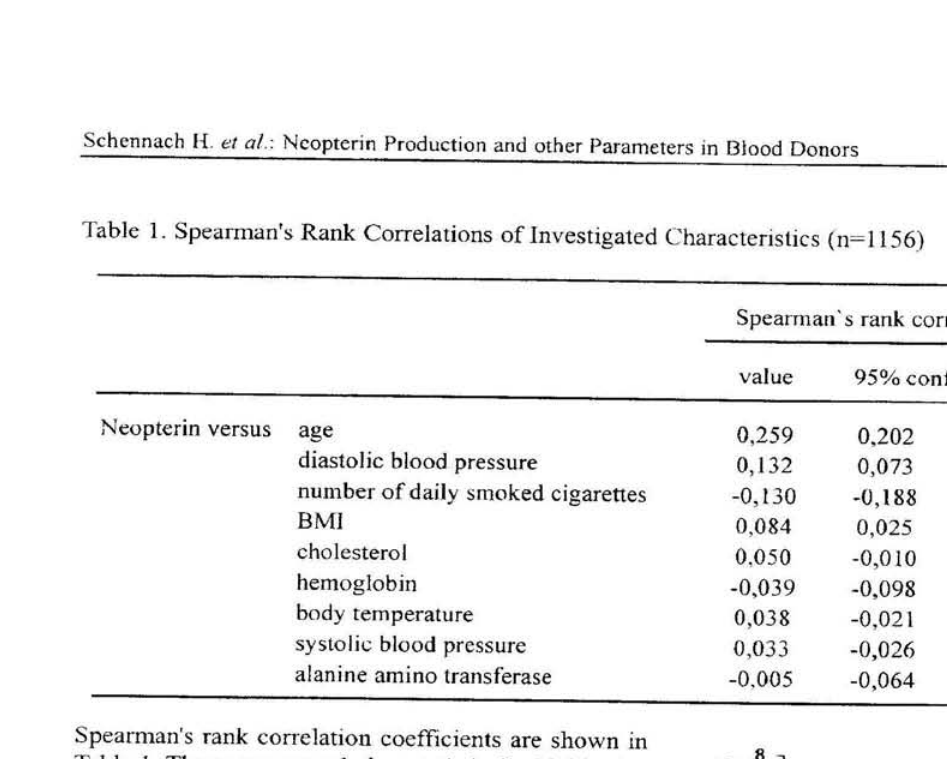
Table 1. Spearman's Rank Correlations of Investigated Characteristics (n=1156)